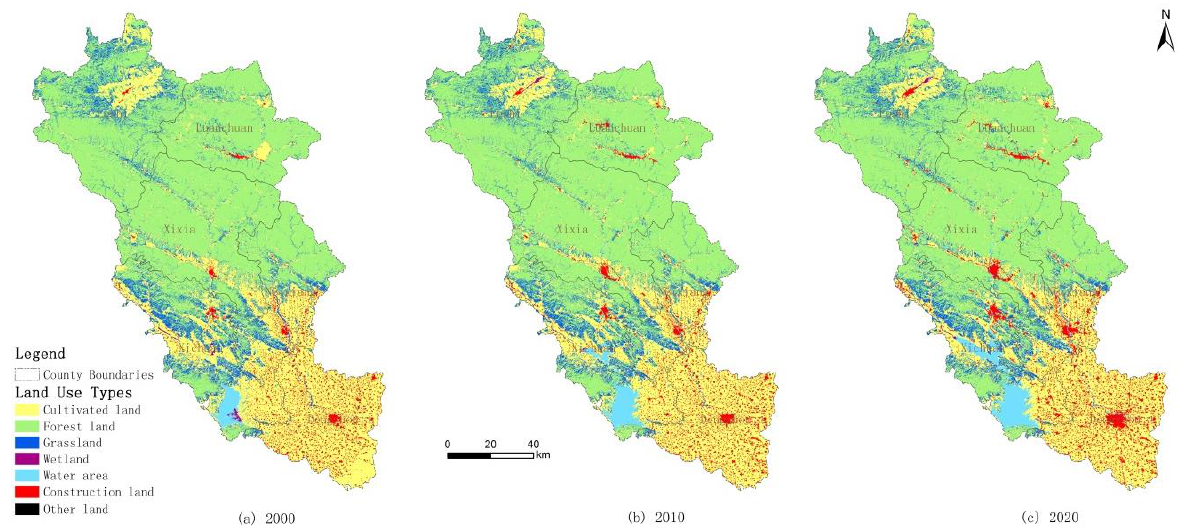
Figure 3. Land use maps in 2000, 2010, and 2020.